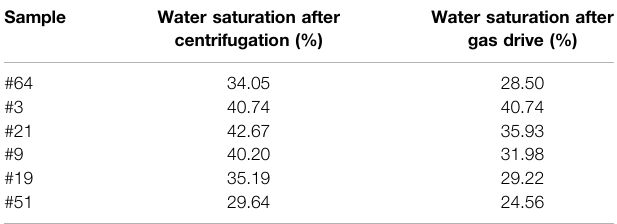
TABLE 2 | Irreducible water saturation of samples after